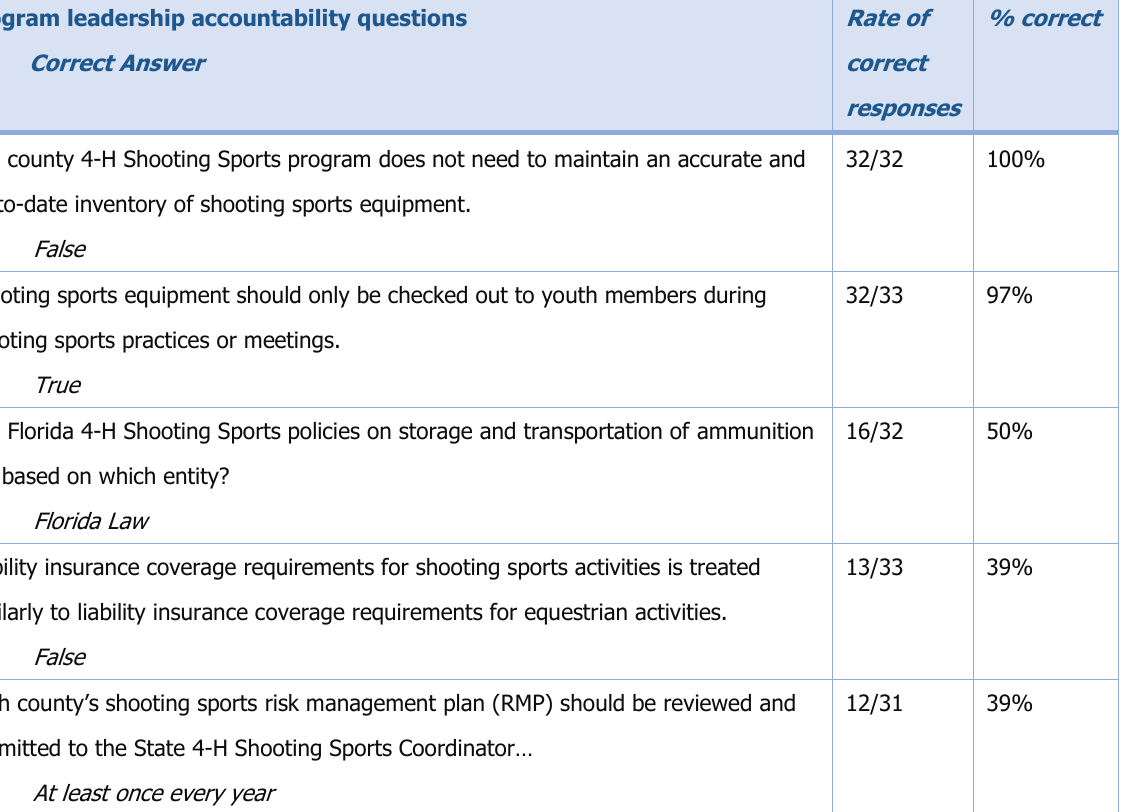
Table 4. Assessment of Respondents’ Knowledge of Program Leadership Accountability